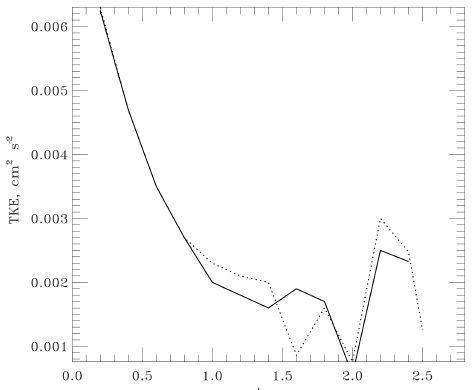
Figure 5. Relative number of activated particles as a function of time N tot = 55 . 5cm − 3 (green curve), N tot = 555cm − 3 (red curve) and N tot = 5550cm − 3 (black curve).